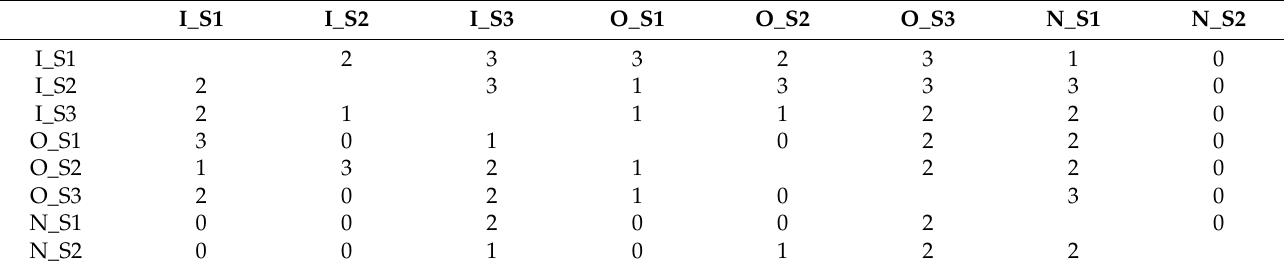
Table A1. Positive cross-impact matrix.